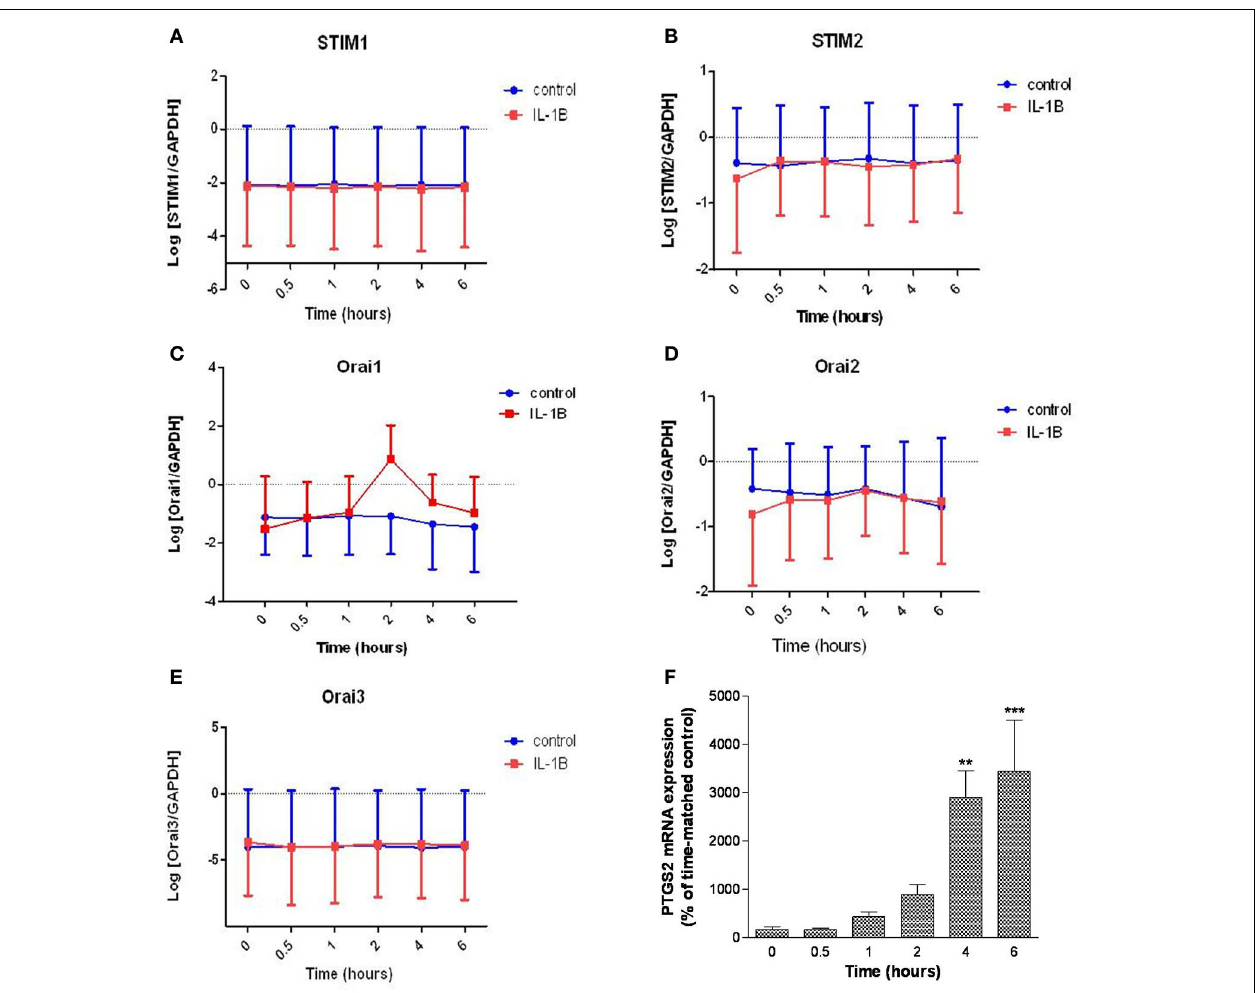
FIGURE 5 | Effect of IL-1 β on STIM1-2 and Orai1-3 mRNA expression in primary hUSMCs. Serum-deprived primary hUSMCs were incubated in the presence or absence of 10ng/ml IL-1 β for up to 6h and mRNA extracted and assessed for (A) STIM1, (B) STIM2,